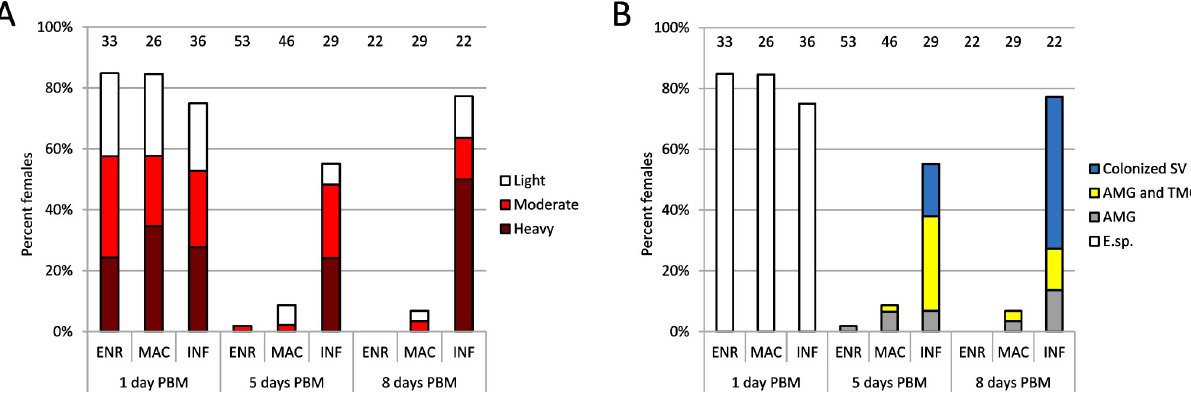
Fig 2. Mundinia development in the sand fly Lutzomyia migonei . Intensity (A) and localization (B) of L . enriettii (ENR), L . macropodum (MAC) and L . infantum (INF) infections. SV, stomodeal valve; AMG, abdominal midgut; TMG, thoracic midgut; E. sp., endoperitrophic space; PBM, post blood meal. Intensity of infection (parasite load) was categorized as light, < 100 parasites per gut; moderate, 100–1000 parasites per gut and heavy, > 1000 parasites per gut. Numbers of dissected females are displayed above the columns. Statistical differences in intensities of infection among Leishmania species were not significant on day 1 PBM (P = 0.860, X 2 = 2.571, d.f. = 6) while significant on day 5 PBM (P < 0.0001, X 2 = 49.922, d.f. = 6) and day 8 PBM (P < 0.0001, X 2 = 44.950, d.f. = 6).